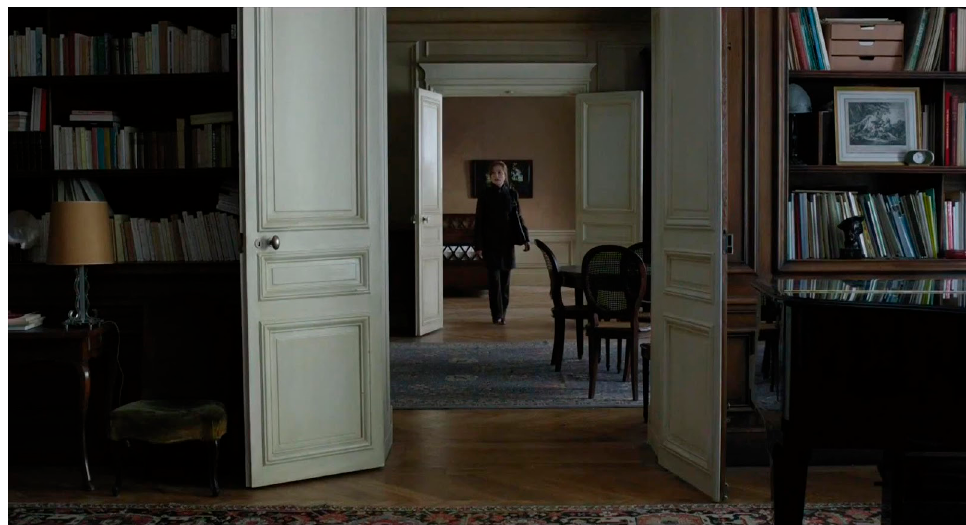
Figure 9. Georges and Anne’s daughter visits their empty home.